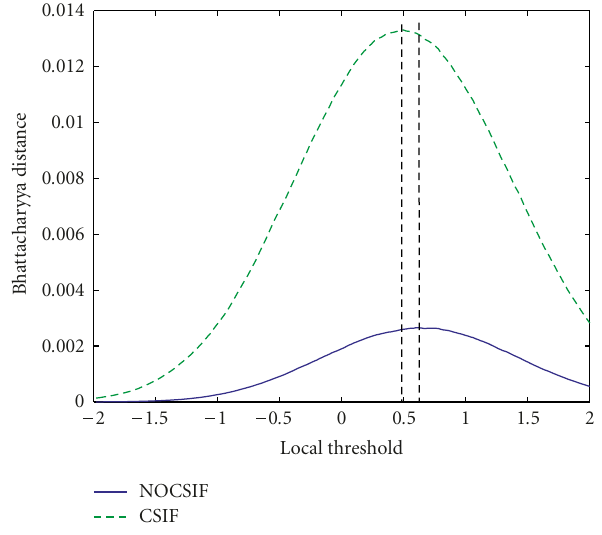
Figure 4: Bhattacharyya’s distance versus the local threshold at the local sensors.